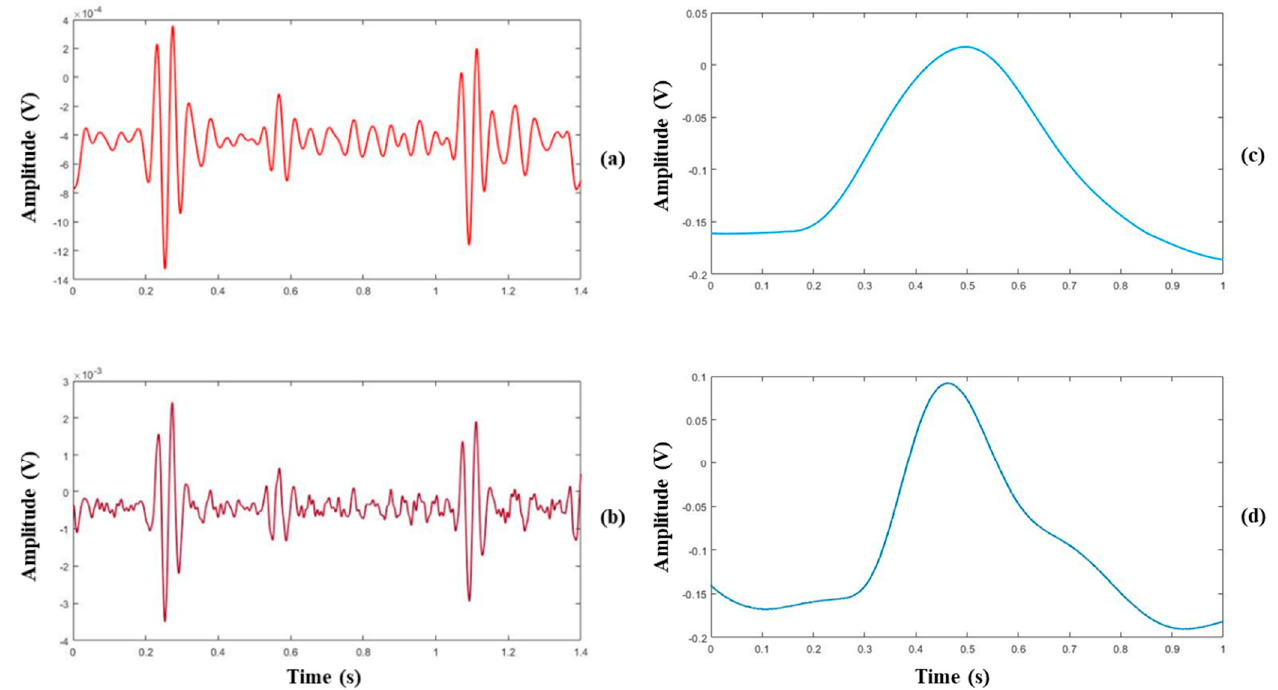
Figure 6. Example of heart sound (PCG) and pulse (PPG) signal measured by the prototype and MP160: ( a ) PCG signal delineated by the prototype device; ( b ) PCG signal delineated by MP160; ( c ) PPG signal delineated by the prototype; ( d ) PPG signal delineated by MP160.